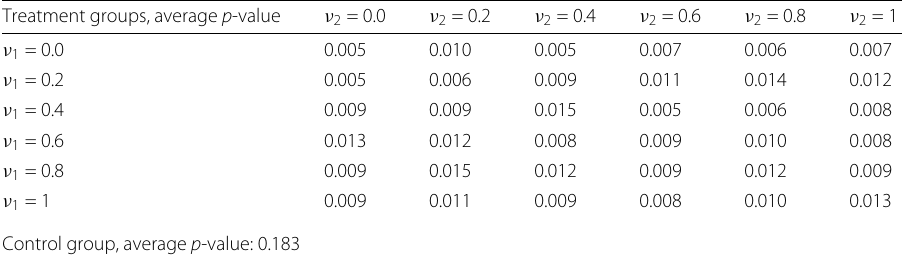
Table 4 Treatment groups: average p -values for goodness-of-fit tests of power-law models to in-degree distributions of interaction networks in online communities, with no onboarding (control group) and with onboarding Treatment groups, average p -value ν 2 =